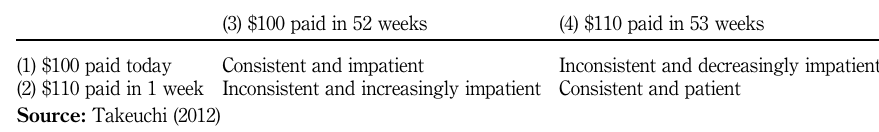
Table I. Decreasing impatience, increasing impatience and consistent